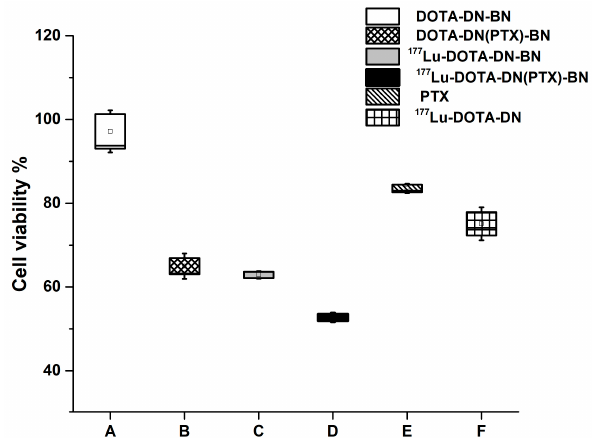
Figure 6. Cell viability after seven days of treatment with DOTA-DN-BN ( A ), DOTA-DN(PTX)-BN ( B ), 177 Lu-DOTA-DN-BN ( C ), 177 Lu-DOTA-DN(PTX)-BN ( D ), Paclitaxel ( E ), 177 Lu-DOTA-DN ( F ). Reduction on cell viability was inherent to the presence of PTX or 177 Lu. As expected, there was no statistical significance between the cell uptake of DOTA-DN(PTX)-